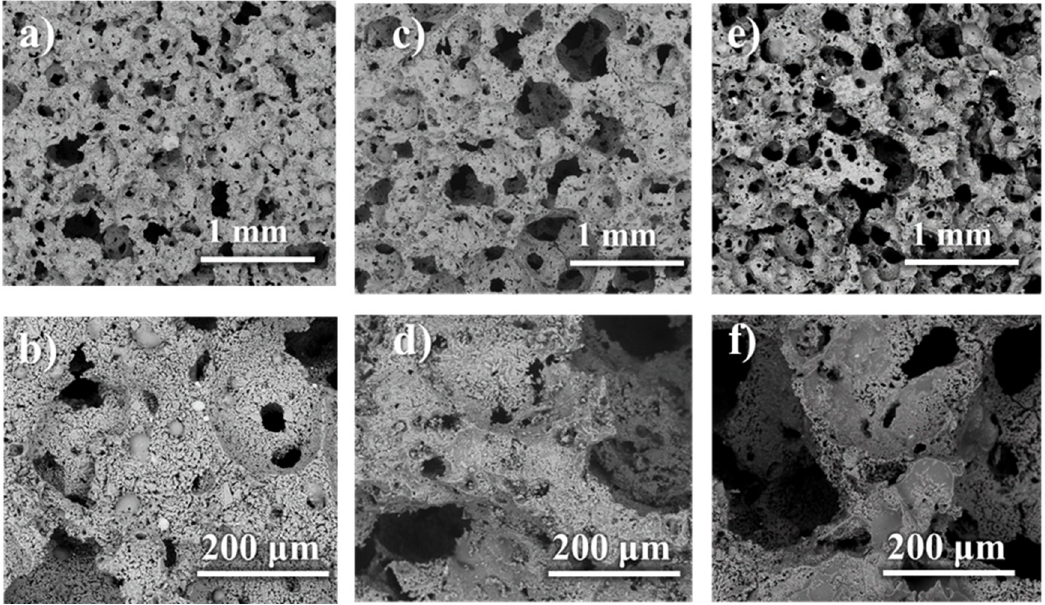
Figure 7. SEM pictures of VBA–BSG foams fired at 850 °C ( a , b ), 900 °C ( c , d ), and 950 °C ( e , f ).